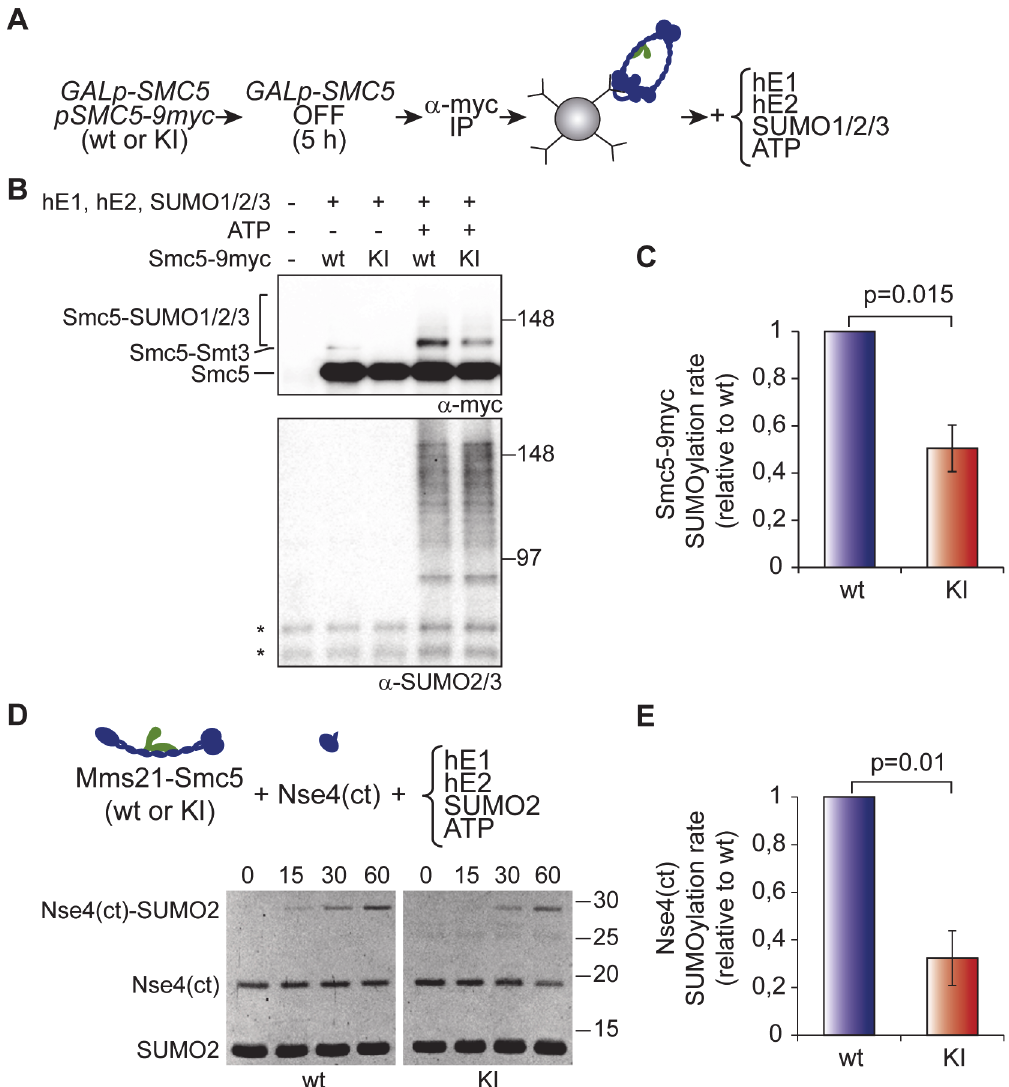
Fig 5. Binding of ATP to the ATPase head of Smc5 stimulates sumoylation in vitro. A . Experimental outline for the purification of wild-type or K75I mutant Smc5/6-Mms21 complexes used in the reactions. B . In vitro sumoylation reactions on immunoprecipitated Smc5-9myc. Reactions were stopped after 1 h of incubation at 37°C with the human E1, E2, and SUMO enzymes, as described in Materials and Methods, and analyzed by SDS-PAGE and immunoblotting using the indicated antibodies. C . Quantification of in vitro sumoylation rate in immunoprecipitated Smc5/6-Mms21 complexes, as described in Materials and Methods. Graph shows mean ± s.e.m.; n = 4; for each individual experiment, the rate of sumoylation for wild — type Smc5 was set to 1. D . In vitro sumoylation assay of the c-terminal domain (ct) of Nse4 (residues 246 to 402), using the Smc5-Mms21 heterodimer as the E3. Reactions were initiated by addition of ATP (time 0) and stopped at the indicated times. Samples were loaded in SDS-PAGE gels and stained with SYPRO-Ruby. E . Quantification of Nse4(ct) sumoylation rates, as described in Materials and Methods. Graph shows mean ± s.e.m.; n = 4; for each experiment, the rate of sumoylation using wild-type Smc5 was set to 1. wt = wild type; KI = smc5(K75I) . In B, asterisk marks unspecific band detected by the anti-SUMO2/3 antibody in